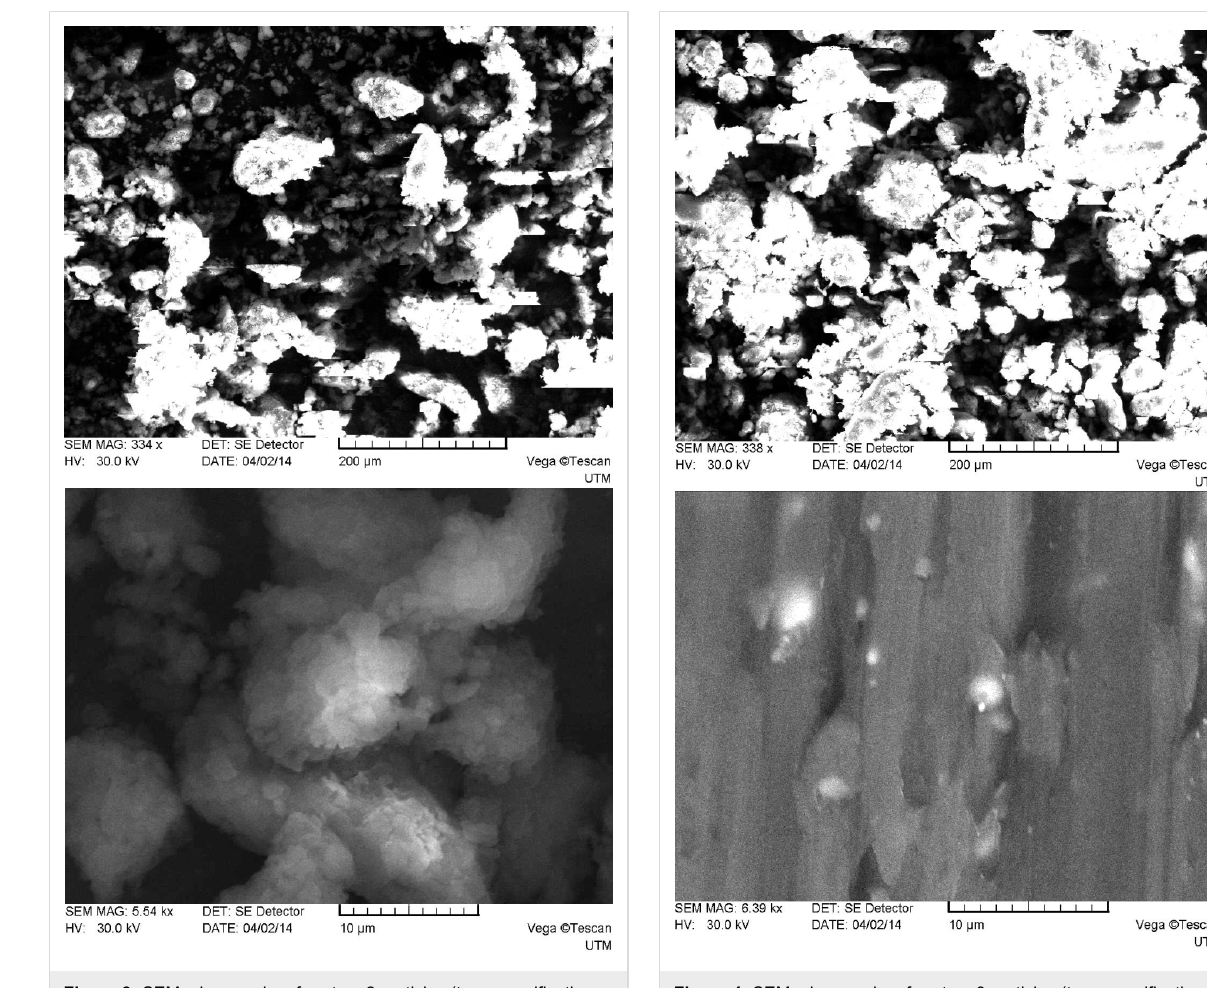
2858 cm − 1 (C-H asymmetric stretching), 3006 cm − 1 (C–H sym- metric stretching) and 3303 cm − 1 (N-H stretching). This